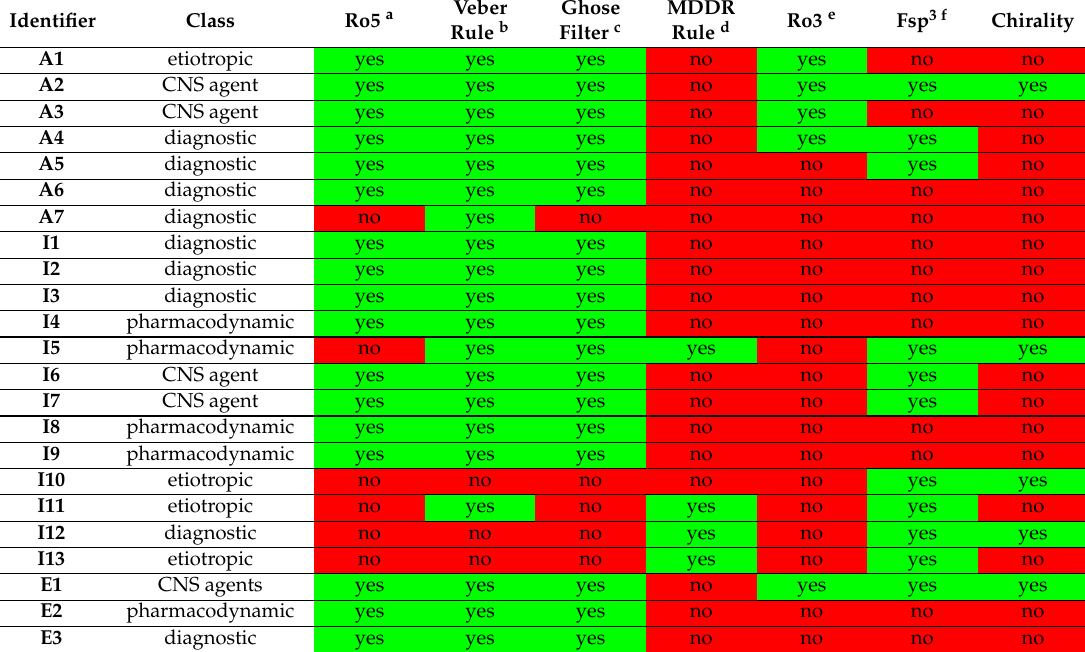
Table 2. Good-quality criteria applied to 1,3-benzothiazole drugs included in DrugBank [3]. Identifier